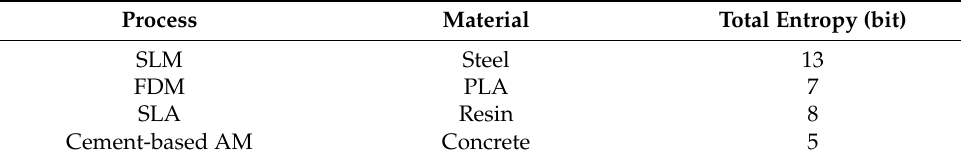
Table 4. Process parameter (PP)–KPI coupled complexity.